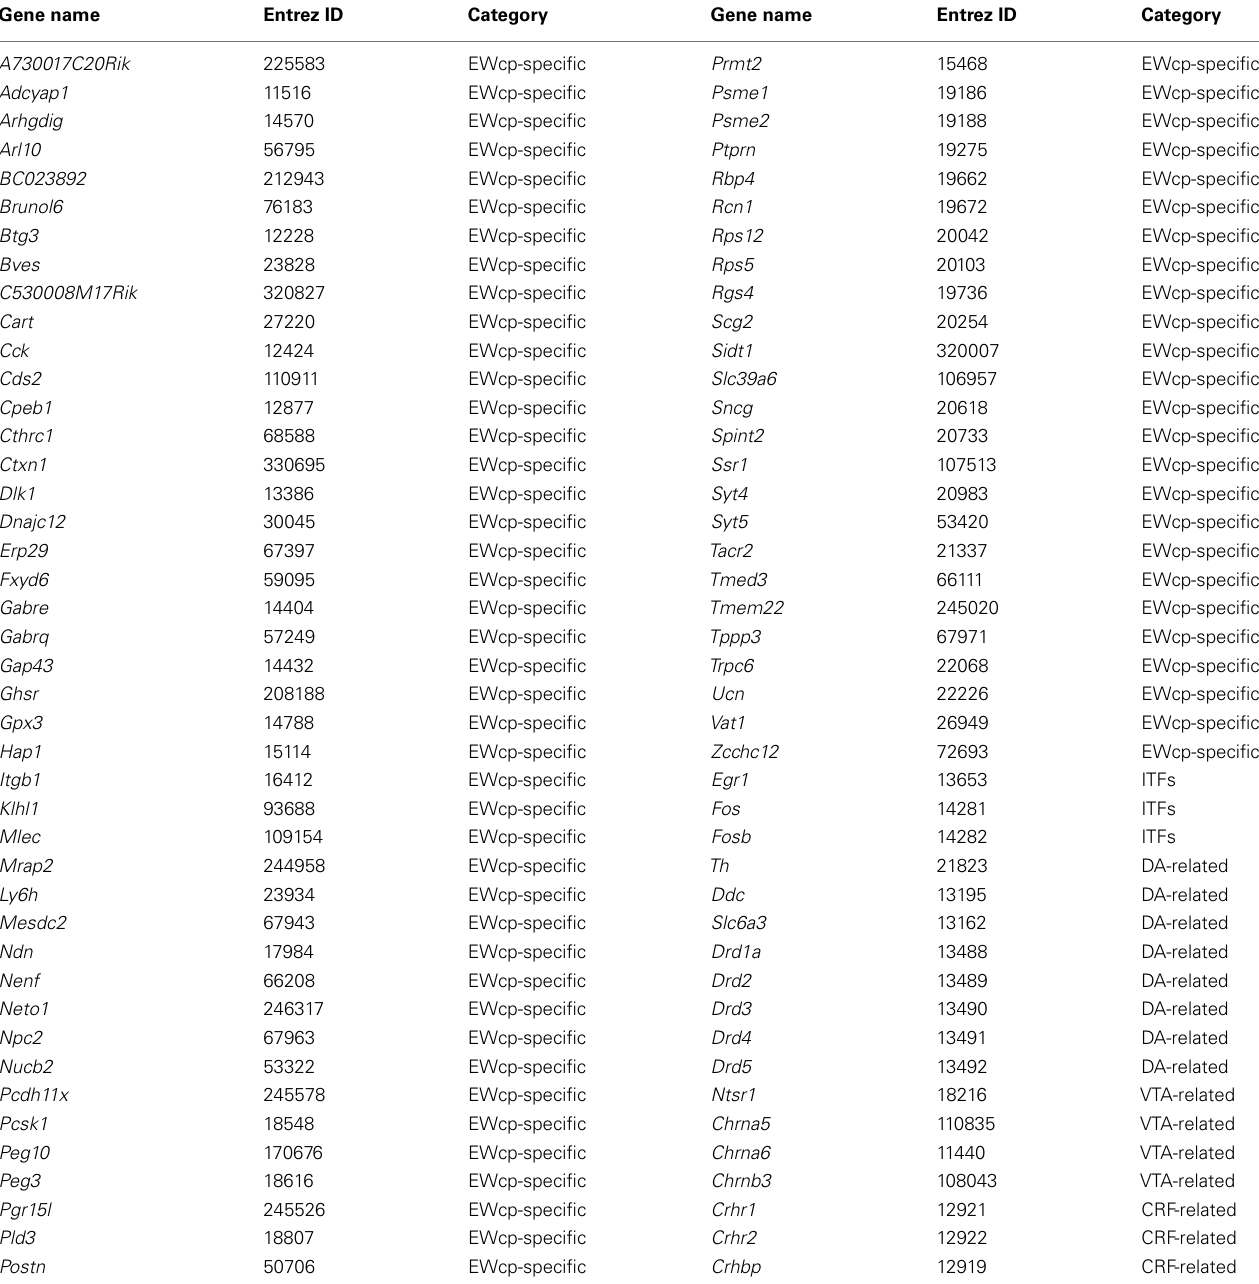
Table 1 | Complete list of all genes of interest included in the